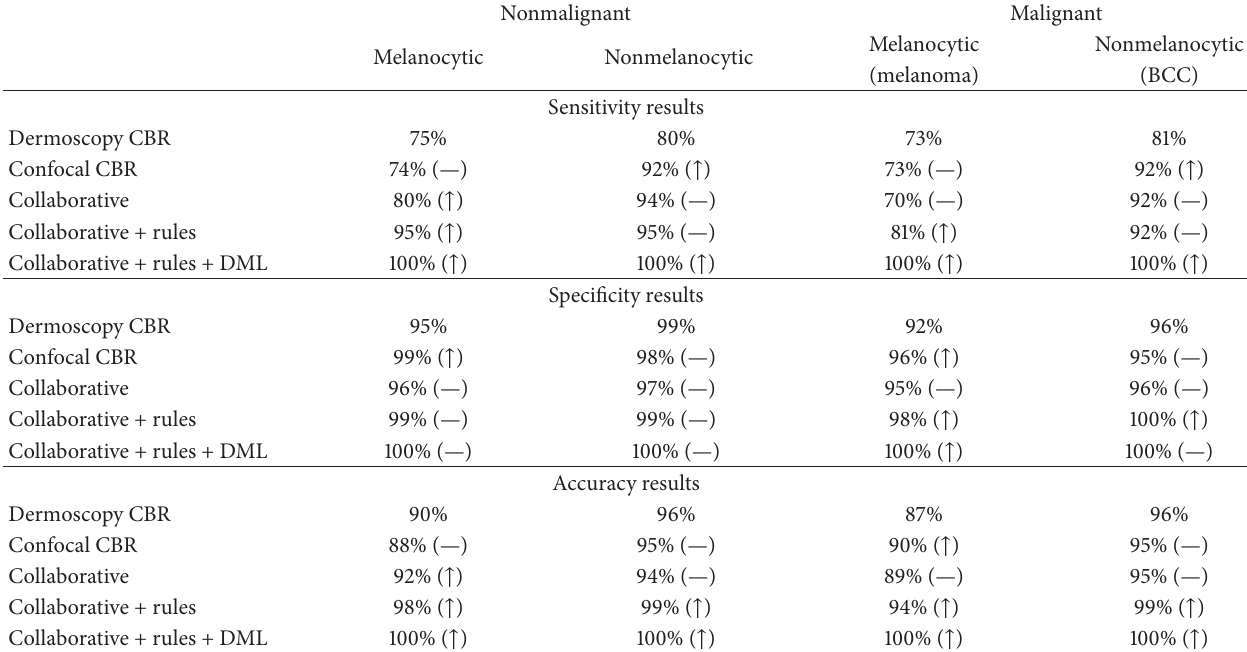
Table 1: Sensitivity, specificity, and accuracy results obtained in melanocytic, melanoma, and BCC classification through the different DERMA challenges: the noncollaborative CBR classification which only uses dermoscopy data, the noncollaborative CBR classification which only uses confocal data, the plain collaborative system, the collaborative system that enhances the collaboration with preprocessing rules, and the collaborative system with a DML organized case memory. Each result shows the 𝑡 -test comparison between the result obtained on this DERMA configuration in comparison with the previous one using 95% of confidence level. This is presented with an ( ↑ ) if it is significantly better and (—) if there is no significant difference.